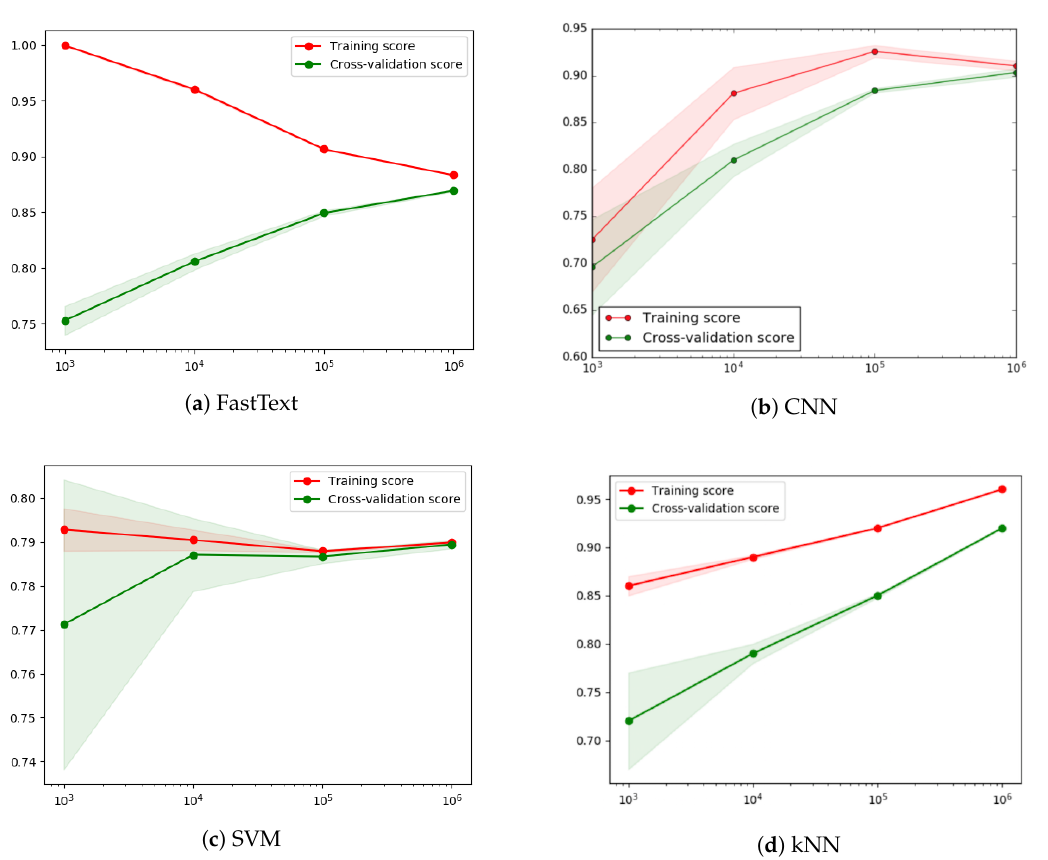
Figure 3. Learning curves with 5-fold cross-validation on the FastText, Convolutional Neural Network (CNN), Support Vector Machine (SVM), and k-Nearest Neighbors (kNN) classifiers. Horizontal axes show the total training samples, whereas vertical axes are the F 1 -score. The green region represents the standard deviation of the